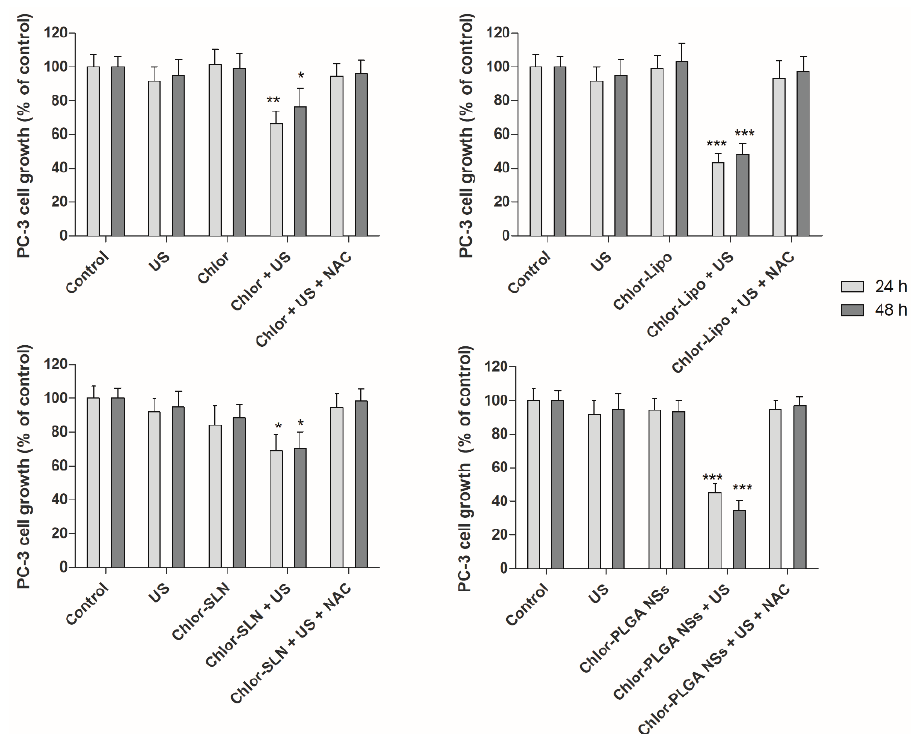
Figure 5. Effect of sonodynamic treatment on PC-3 cell growth. Cells were incubated for 6 h with Chlor-Lipo or Chlor-SLN and for 24 h with Chlor or Chlor-PLGA NSs at the same concentration (5 µM) and then exposed to US at 1.5 MHz for 5 min at 1.5 W/cm 2 . In the graphs is also shown the effect of sonodynamic treatment in presence of the ROS scavenger, N -acetyl-cysteine (NAC). Before exposing PC-3 cells to US, 5.0 mM NAC was added for the last 3 h incubation of the various Chlor formulations, as reported above. Cells were then exposed to US at 1.5 MHz for 5 min at 1.5 W/cm 2 . Cell growth was evaluated after 24 and 48 h by WST-1 assay. Statistically significant difference vs. untreated cells: * p < 0.05, ** p < 0.01, *** p < 0.001.